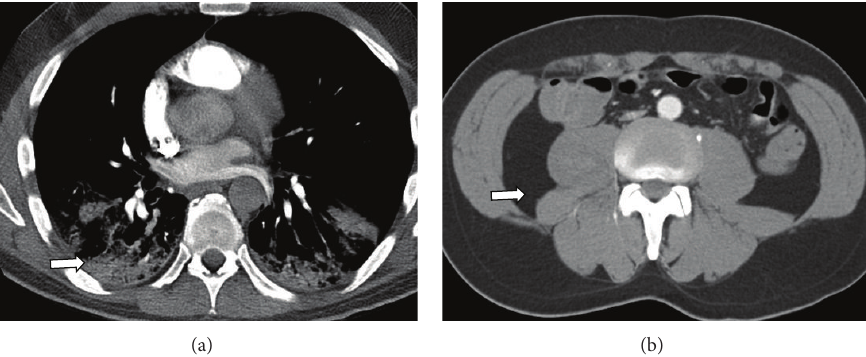
Figure 1: (a) CT chest on admission. Axial contrast enhanced images through the chest in the pulmonary phase demonstrate a normal main pulmonary artery trunk and normal segmental pulmonary arterial branches extending to the superior segment of the right upper lobe. Lung windows reveal lower lobe consolidation (see arrow). (b) Normal appearance of the retroperitoneum at that time (see arrow).